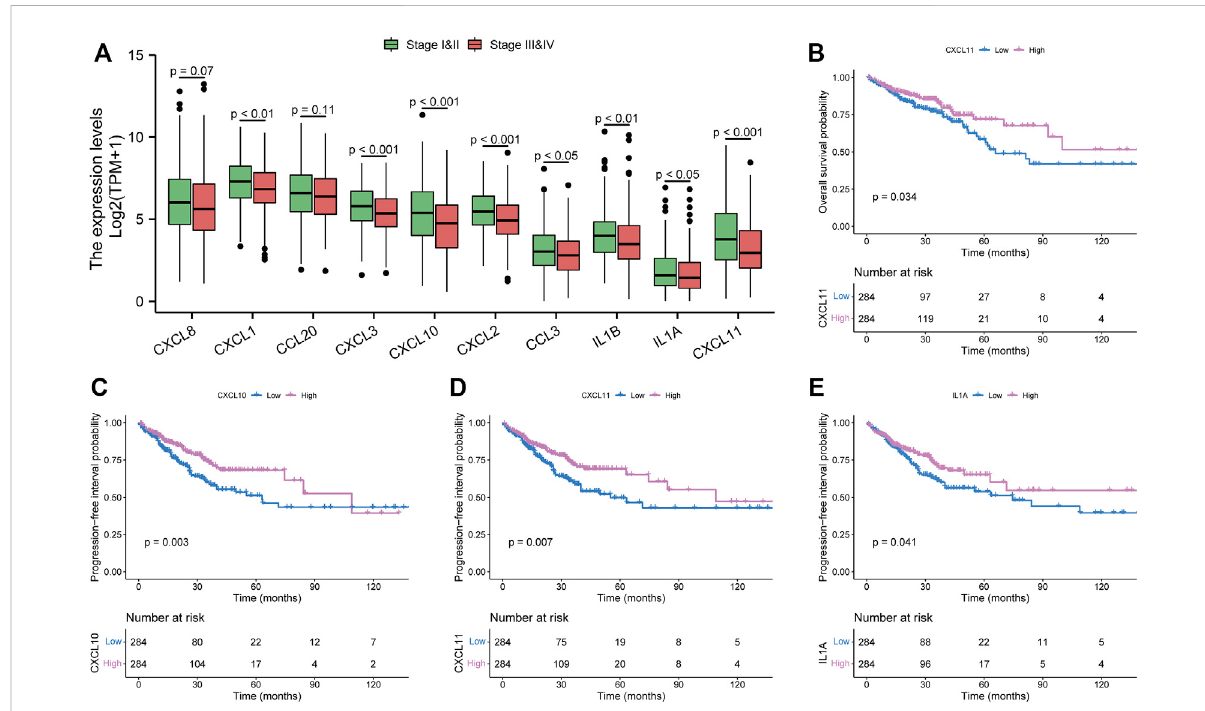
FIGURE 4 Clinical signi fi cance of hub genes in the Cancer Genome Atlas Program cohorts. (A) expression analysis of hub genes in different tumor stages. (B) overall survival analysis of CXCL11. (C – E) progression-free interval analysis of CXCL10, CXCL11, and IL1A,